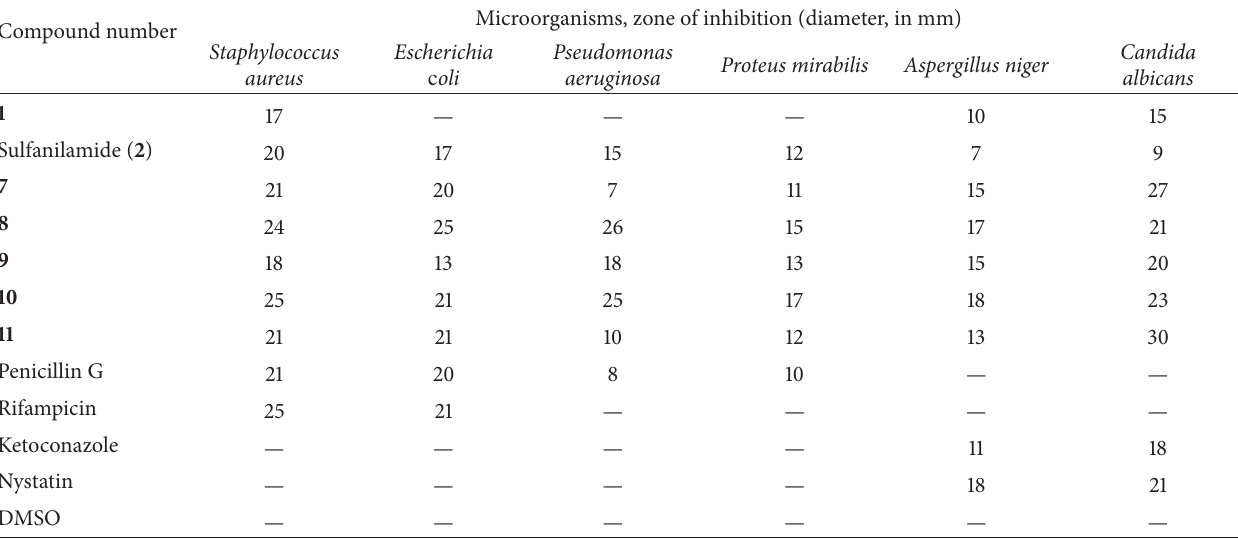
Table 1: The in vitro antimicrobial activity of the synthesized compounds and the control drugs (1mg/mL). Compound number